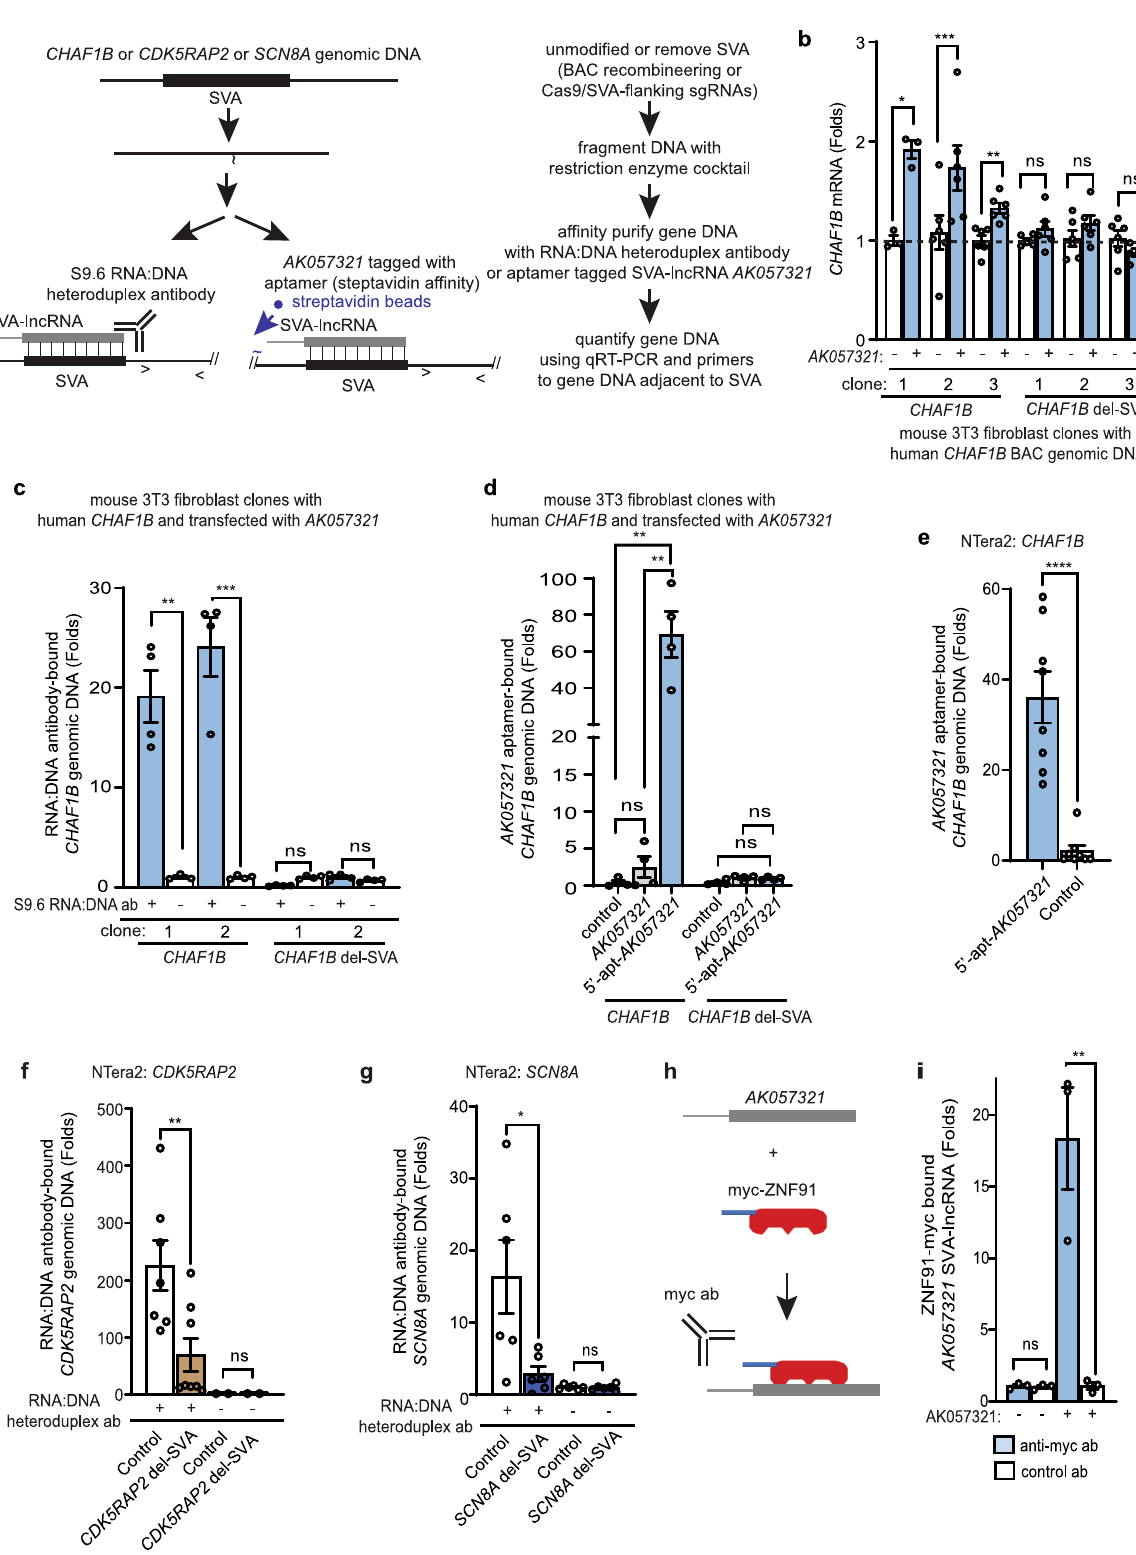
from clones with the SVA present but not those with the SVA deleted (Fig. 7d). In addition, 5 ′ -aptamer tagged AK057321 co- precipitates the CHAF1B genomic DNA in NTera-2 cells (Fig. 7e). Altogether these data show SVA-lncRNA AK057321 af fi nity puri fi es intronic SVA genomic sequences in CHAF1B forming a structure recognized by an RNA:DNA heteroduplex antibody.